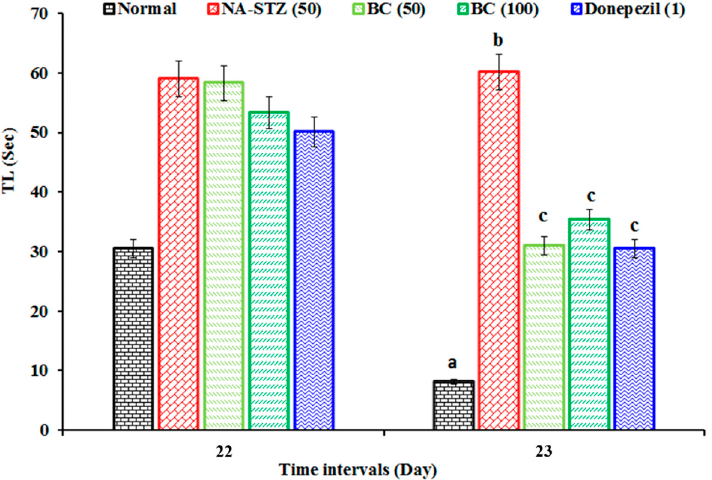
Figure 2. Effect of BC on TL in EPM. Digits in parentheses indicate dose in mg/kg. Data are expressed as mean ± SD; n = 12 rats. a p < 0.05 vs. normal group on day 22; b p < 0.05 vs. normal group on day 23, c p < 0.05 vs. VaD group on day 23.